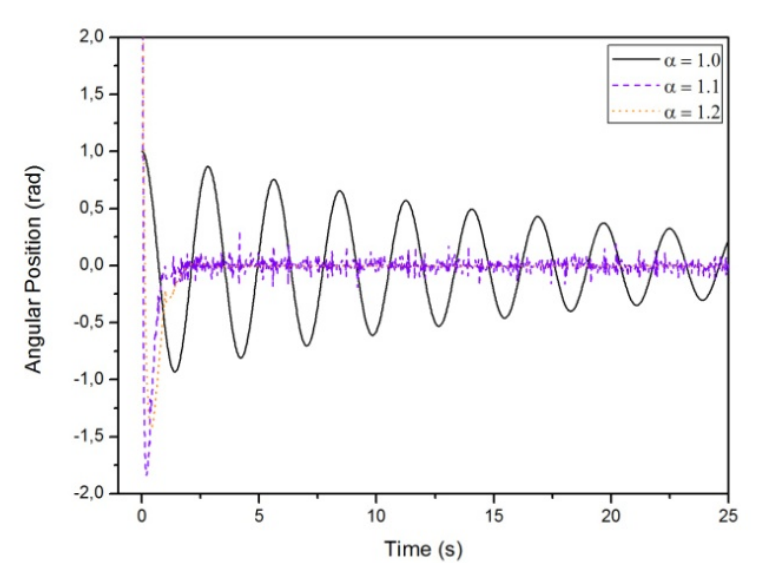
Figure 11. Time history (values of α ≥